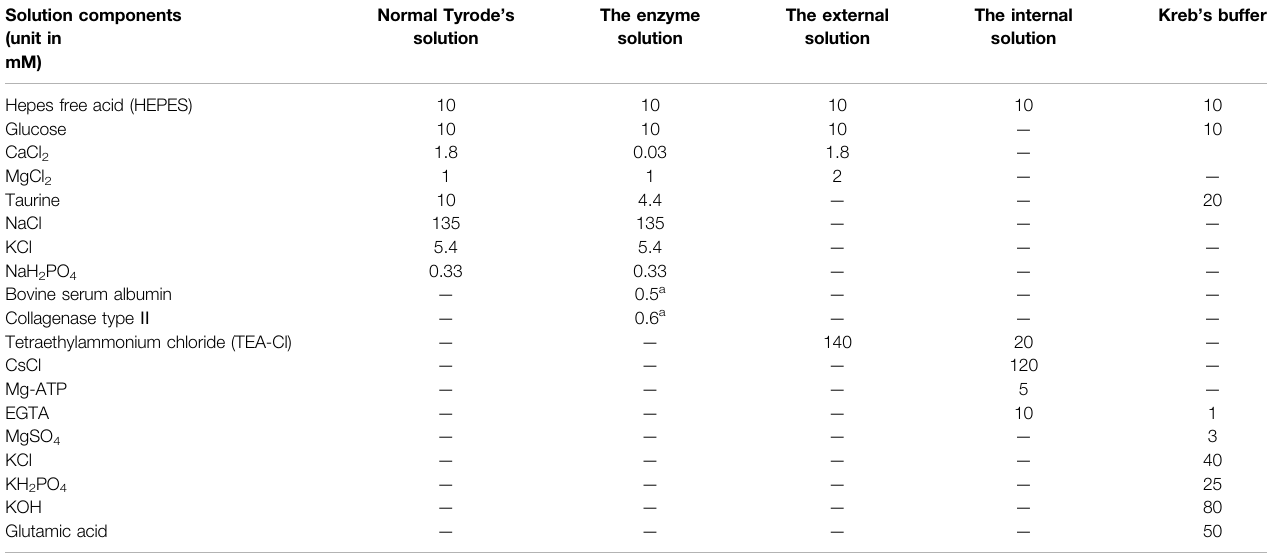
TABLE 1 | Components of solutions used in the study. Solution components (unit in